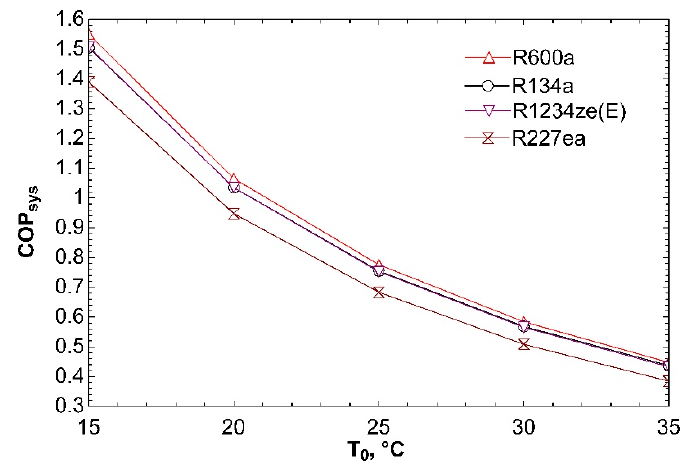
Figure 9. Effect of T 0 on COP sys in combined ORC-single evaporator VCR cycle.